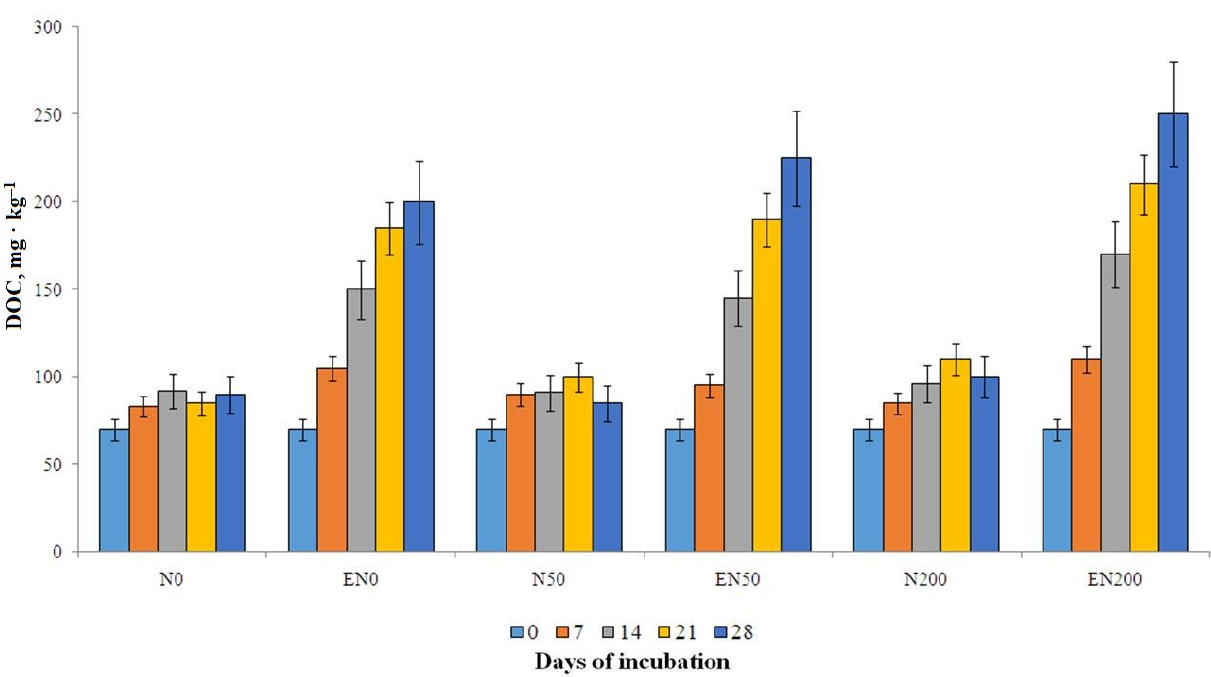
Figure 4. Dissolved organic carbon content in soil (mg kg − 1 ).